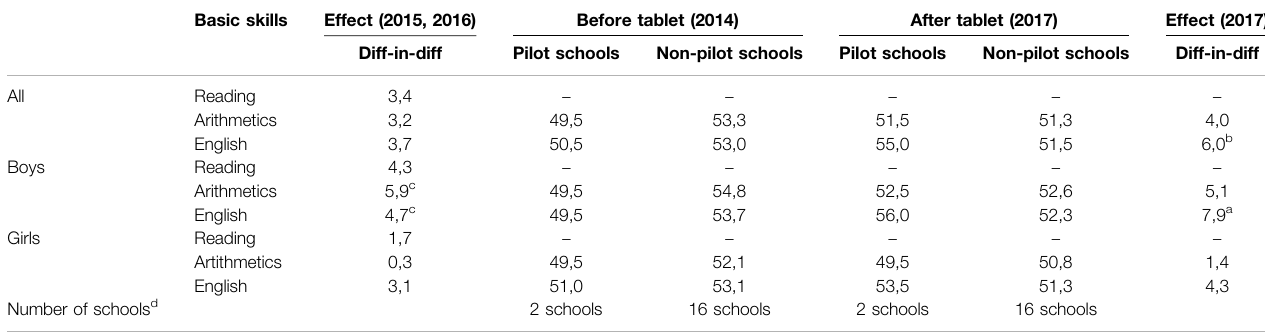
TABLE 2 | Difference-in-difference analysis of fi fth grade test results (Pilot 1 schools).